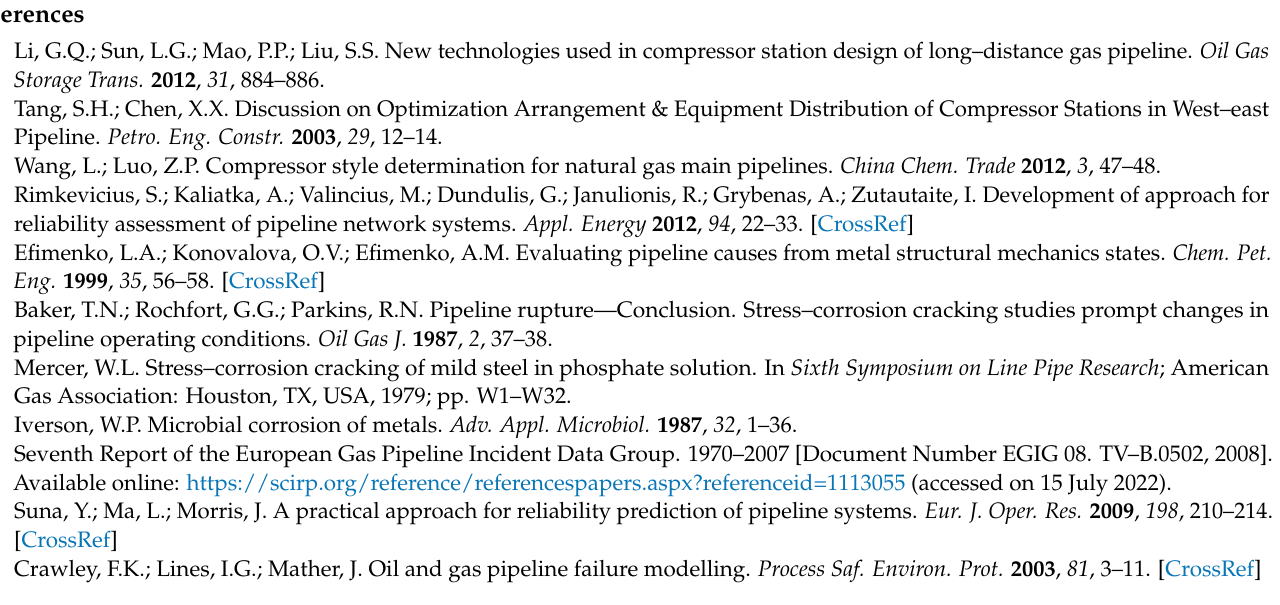
Figure S2: Principle diagram of importance sampling method; Figure S3: Principle diagram of modified importance sampling method; Figure S4: Main line graph under design condition; Table S1: Compressor shaft